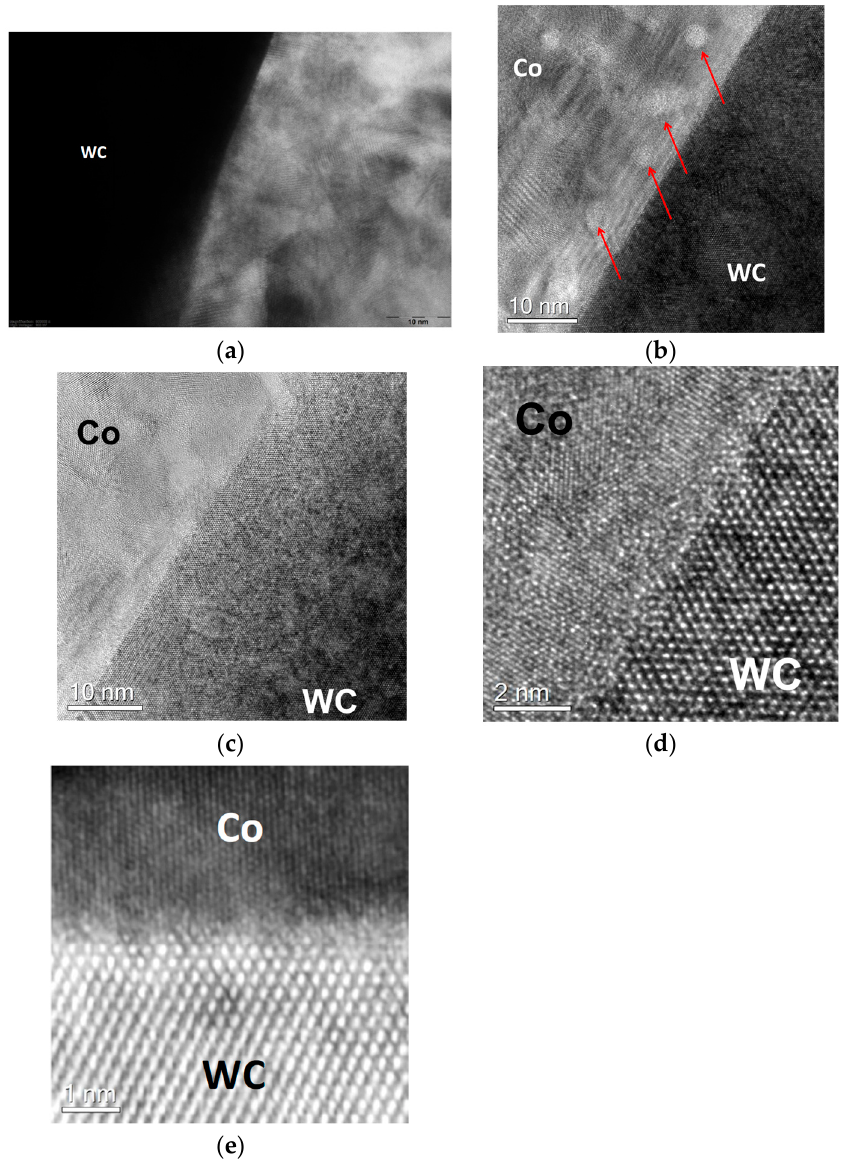
Figure 4. WC-Co interfaces in the sample obtained after melting the alloy with the medium-low carbon content on the WC surface: ( a ) Binder nano-structure near the interface (JEOL JEM-2100); ( b – d ) Aberration corrected high-resolution transmission electron (HRTEM) images of the interface at different magnifications (nanoparticles in the Co-based alloy are indicated by arrows), ( e ) High Angle Annular Dark Field Scanning TEM (HAADF STEM) after gamma-correction and high-pass filtering (FEI Titan